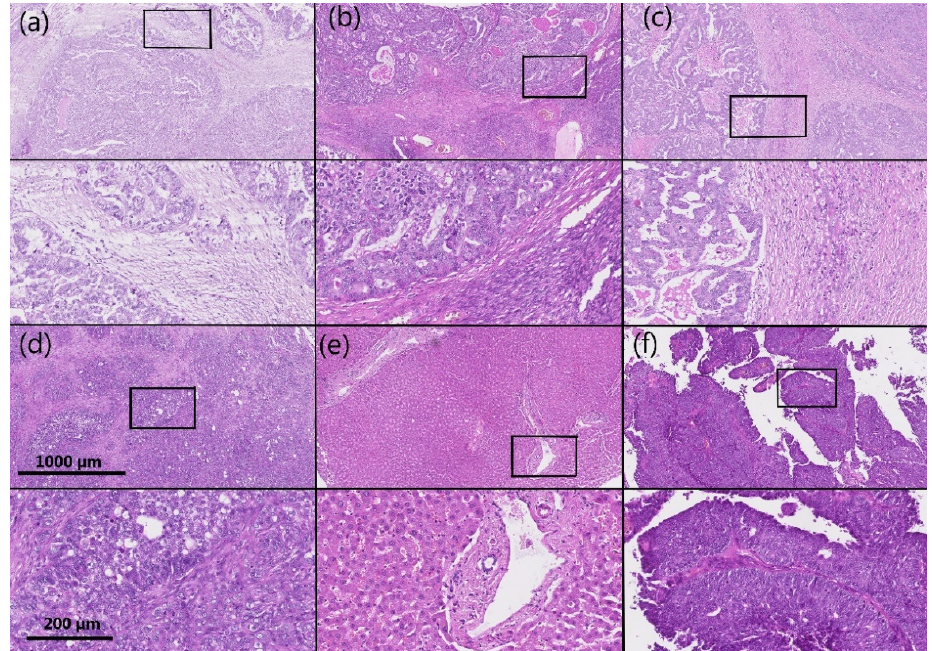
Figure 3. Representative hematoxylin and eosin staining of the same samples as shown in Figure 2. ( a – d ) HGSC; ( e ) control liver tissue; ( f ) control endometrioid endometrial cancer. Upper half of panels: 50 × magnification; lower half of panels: the framed area from the upper half of the panel (200 × magnification). HGSC: high-grade serous ovarian cancer.